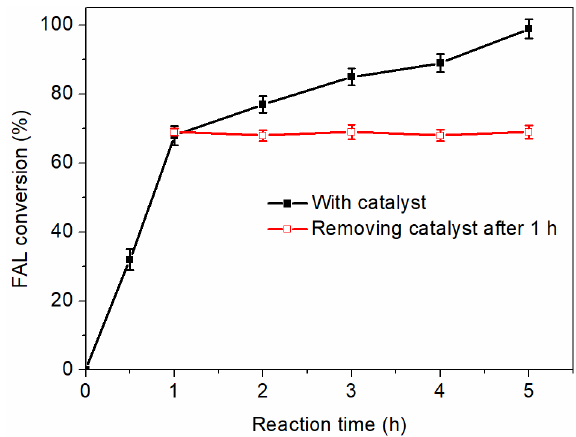
Figure 12. Hot filtration experiment of Pd/UiO-66-NO 2 - 7 . Reaction conditions: catalyst (5.0 mg), FAL